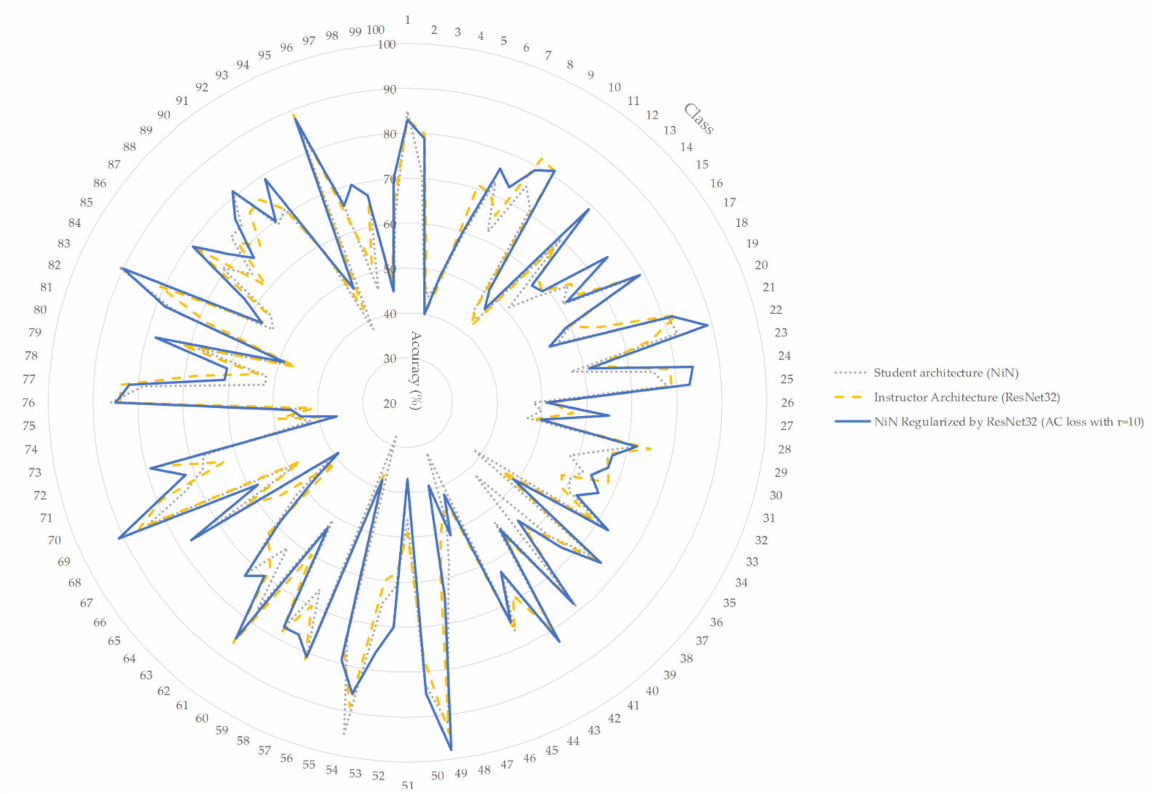
Figure 3. Class-wise accuracy obtained by reference NiN, ResNet32 and regularized NiN via AC loss in